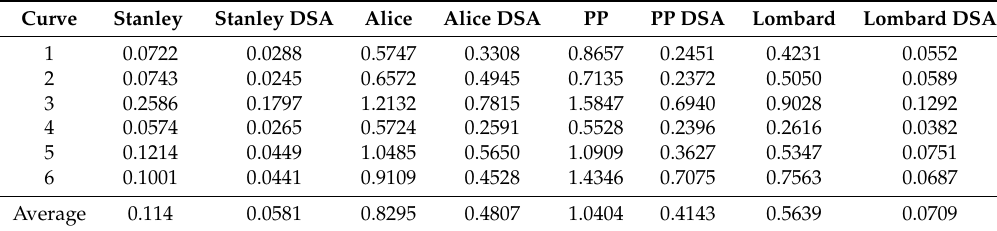
Table 3. Error comparison in sharp curves of different lateral control methods for the UTBM-2 dataset. Results are expressed in meters.